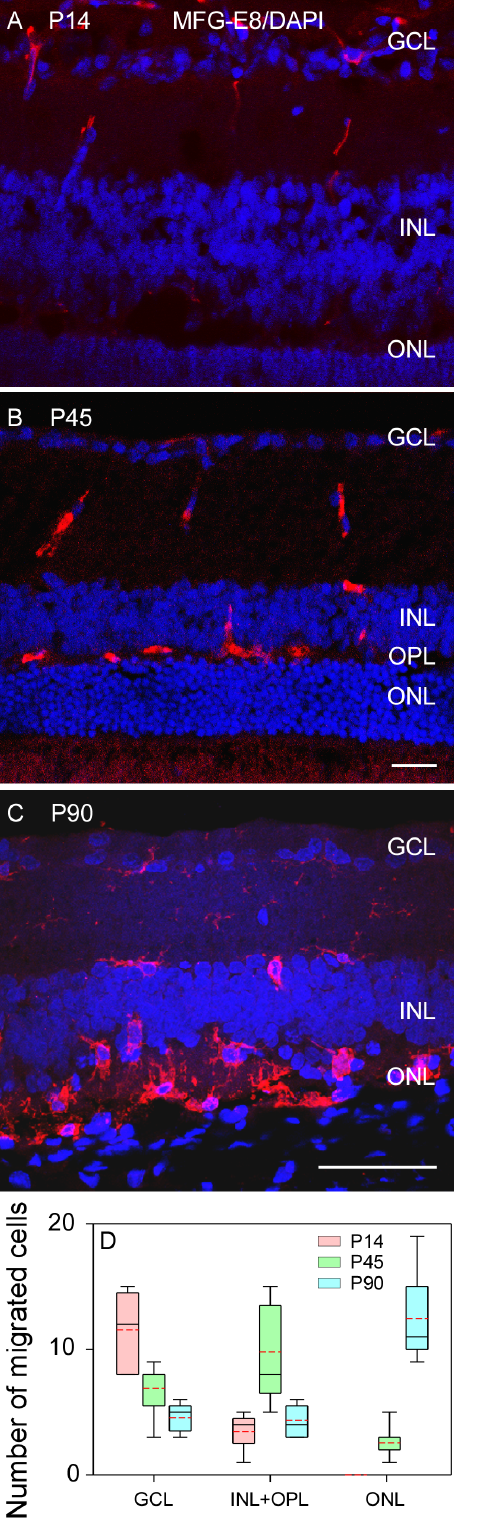
Figure 2. The distribution of MFG-E8 positive cells in the ganglion cell layer (GCL) to the outer layers of the retina during retinal degeneration in RCS rats. (A) MFG-E8 positive cells are mainly scattered in GCL at P14. (B) At P45, MFG-E8 positive cells were detected in the entire inner retina and outer plexiform layer (OPL).